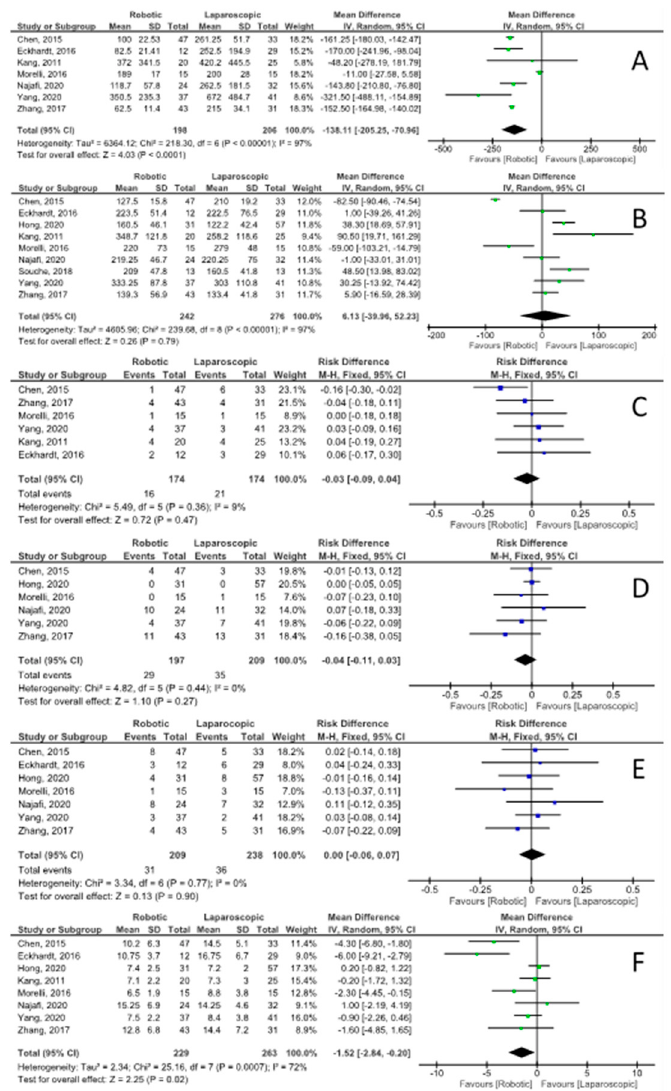
Figure 3. Secondary outcomes forest plots: ( A ) intraoperative blood loss (mL); ( B ) operative time (min); ( C ) perioperative blood transfusions; ( D ) Clavien–Dindo grade ≥ 3 complications; ( E ) postop- erative pancreatic fistula grade B/C; ( F ) hospital length of stay (days).